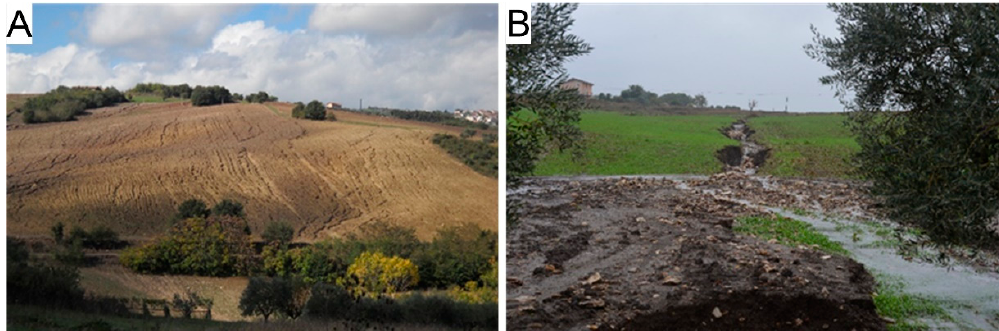
Figure 13. Debris flows initiated by rilling: ( A ) Coalescing rills; ( B ) eroded gully and initial part of debris depositional fan area.